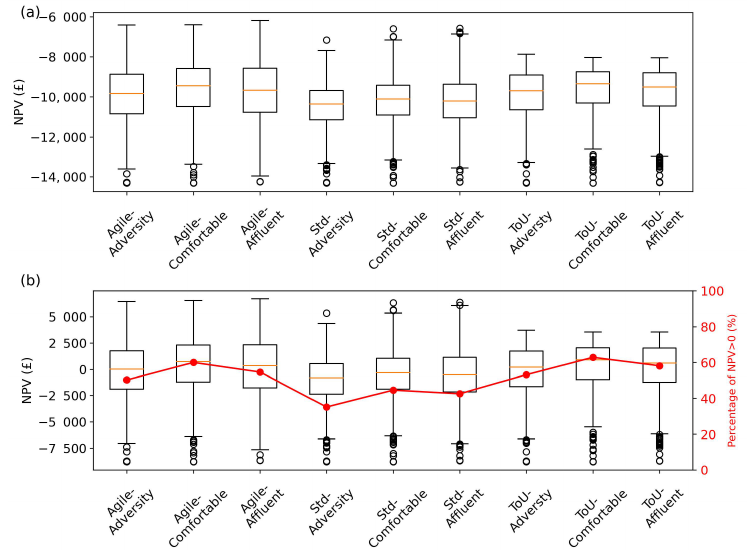
Figure 7. Boxplots of NPV distributions for the fixed PV + BES system segmented by ACORN consumer groups under all of the applied tariffs. ( a ) Fixed configuration NPVs for baseline cost scenario. ( b ) Fixed configuration NPVs for future cost scenario. The red line illustrates the percentage of consumers in the group for whom the PV + BES system has NPV > 0.